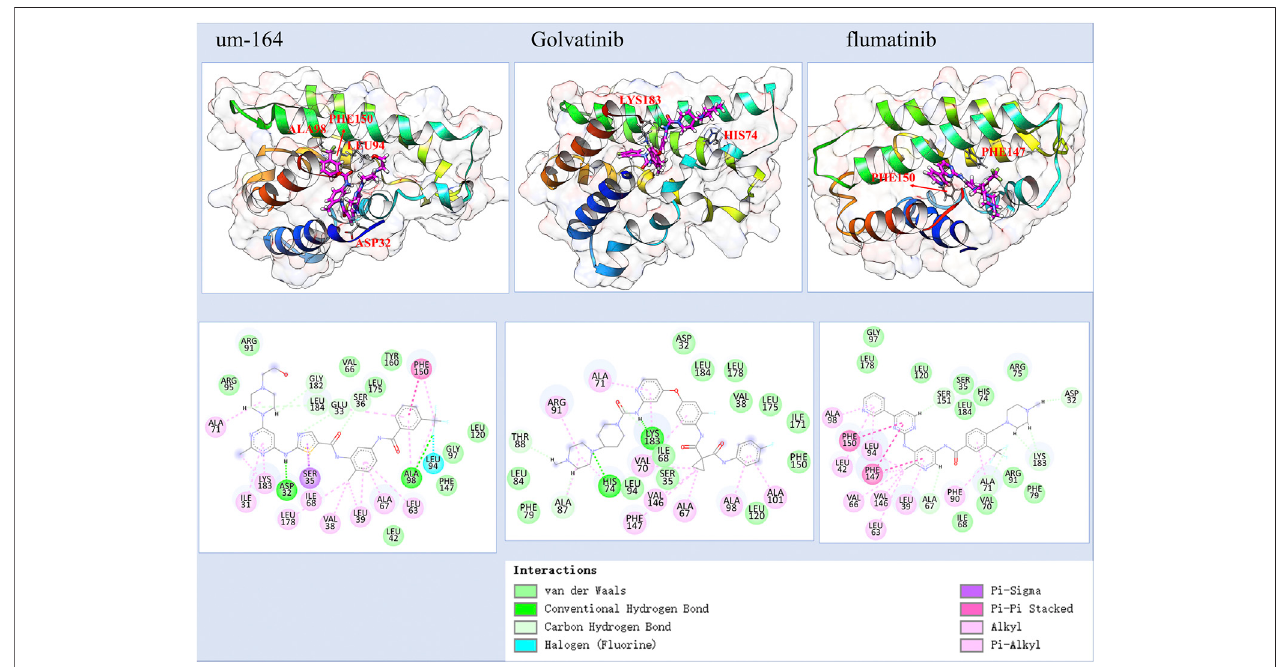
FIGURE2| Thepredictedatomicinteractiondetailsofthethreeexperimentalvalidatedpotentcompounds,amongthem,UM-164hasthestrongestbindingaf fi nity with a K D value of 4.970 µM.